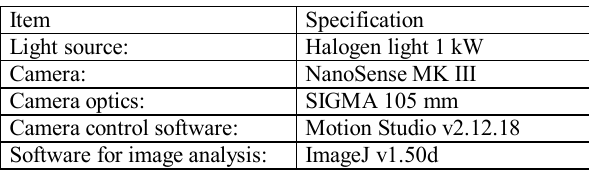
Table 1. Technical parameters of image acquisition system.